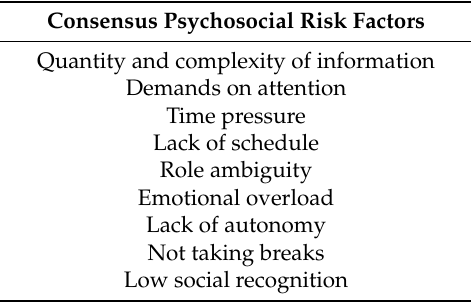
Table 5. Final list of psychosocial risk factors according to expert